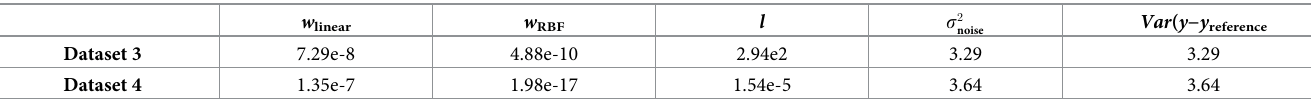
Table 1. Optimized hyper-parameters for hybrid kernel on original datasets